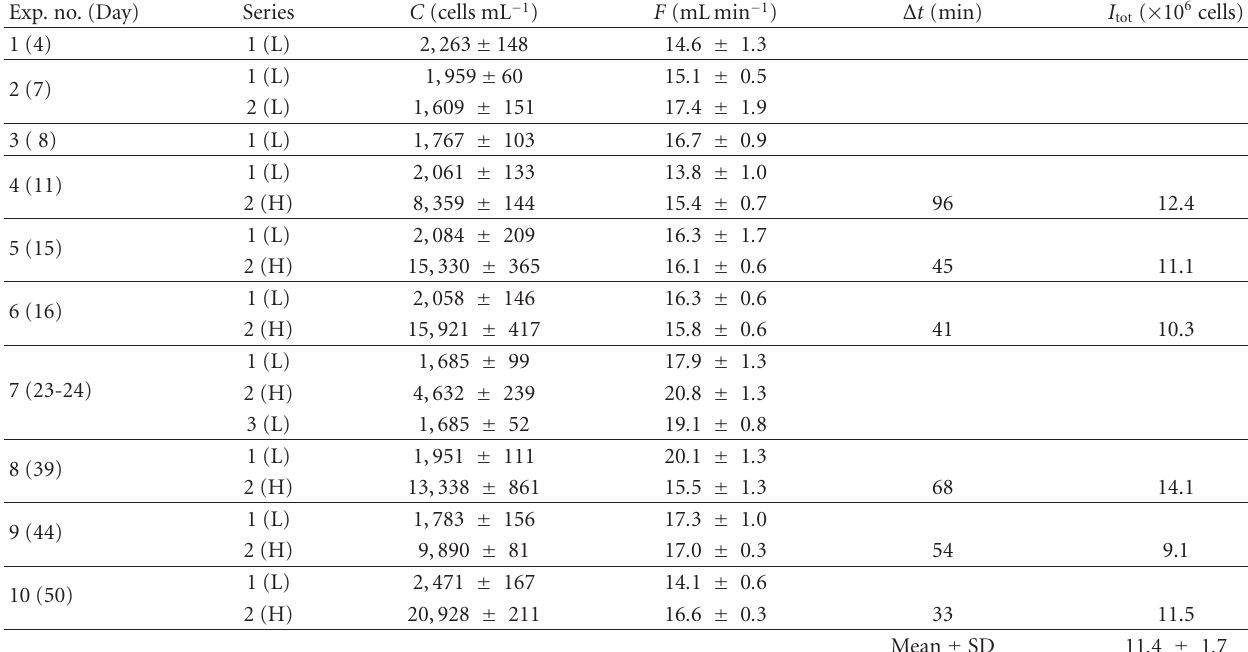
Table 1: Mytilus edulis . Feeding experiments (no. 1 to no. 10) conducted with a group of 20 mussels during a period of 50 days. Series of experiments were conducted at low (L) algal concentration ( C ) before the concentration was increased to a higher (H) level. The mean ( ± SD) steady-state filtration rate ( F ) at first low algal concentration and then at subsequently higher concentration is shown along with the time ( Δ t ) where steady state was maintained at high concentration before incipient saturation (cf. Figure 1). Finally, the total number of algal cells ( Rhodomonas salina ) ingested ( I tot = F × C × Δ t ) before saturation is shown. Exp. no.